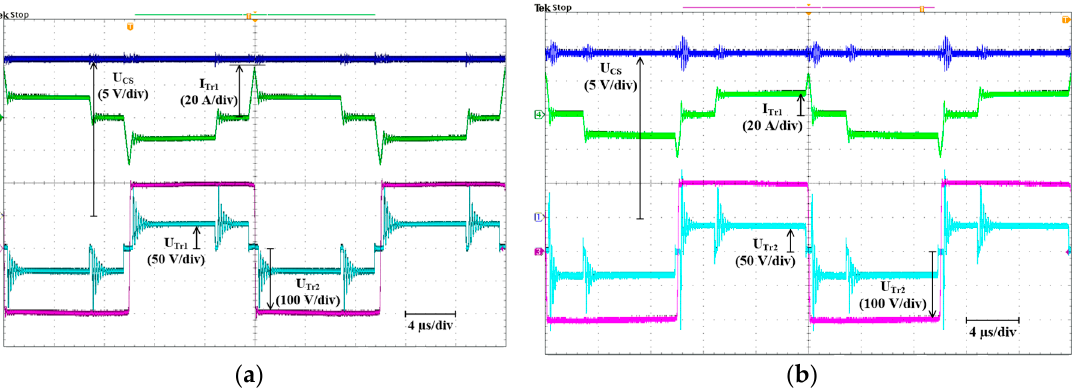
Figure 5. Operating waveforms in the PS-SMC mode: boost ( a ) and buck ( b ). U CS =24 V, P = 300 W.